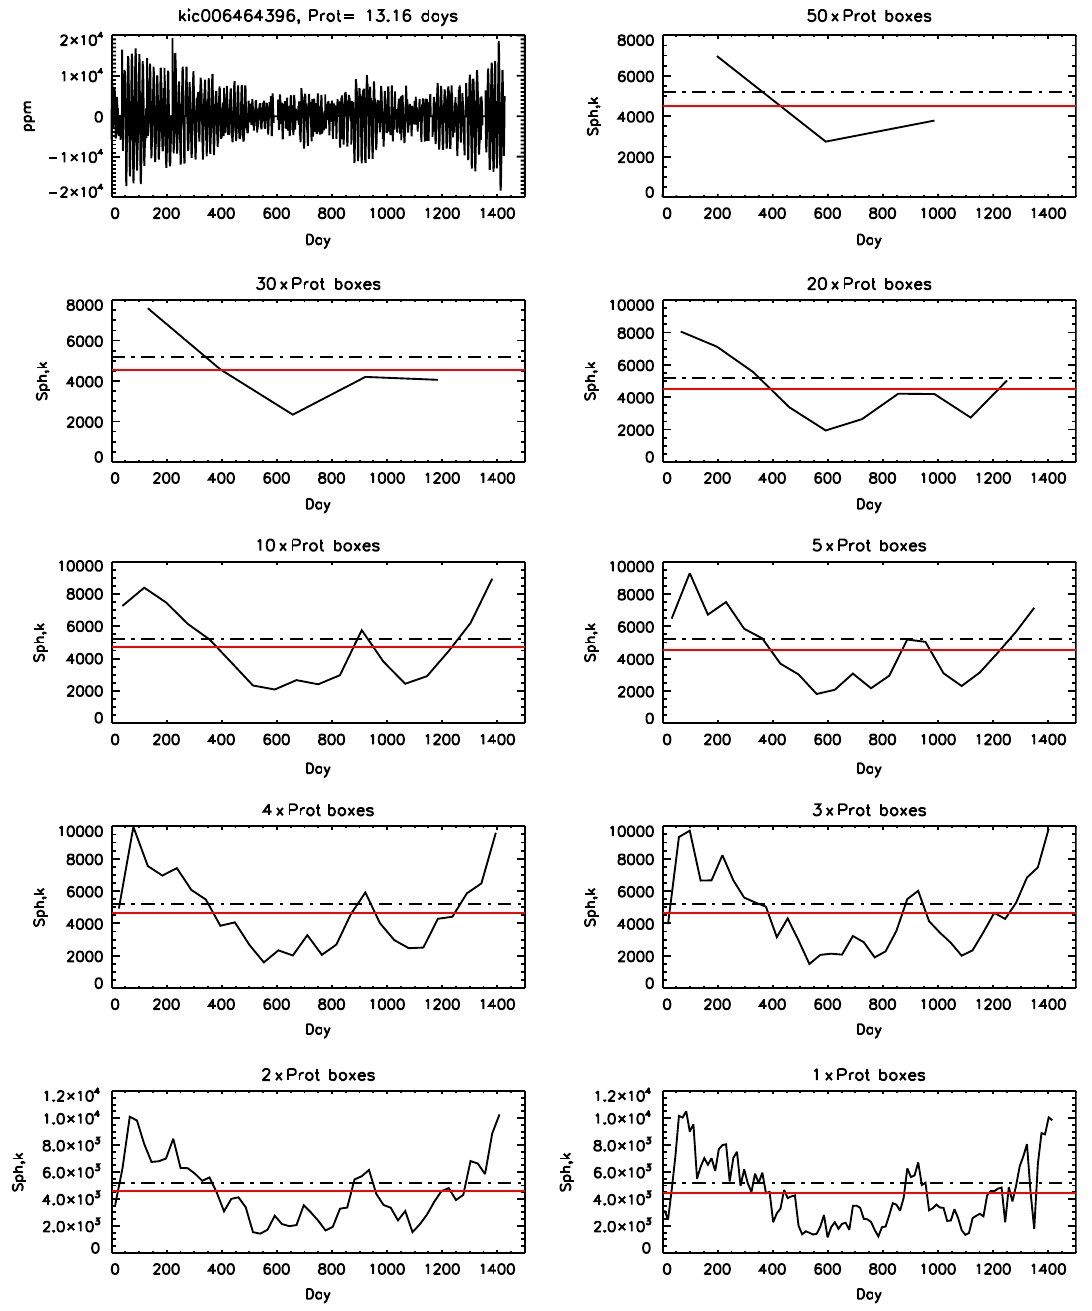
Fig. 2. Temporal variation of the magnetic index S ph, k for the M dwarf KIC 6464396. Same legend as in Figure